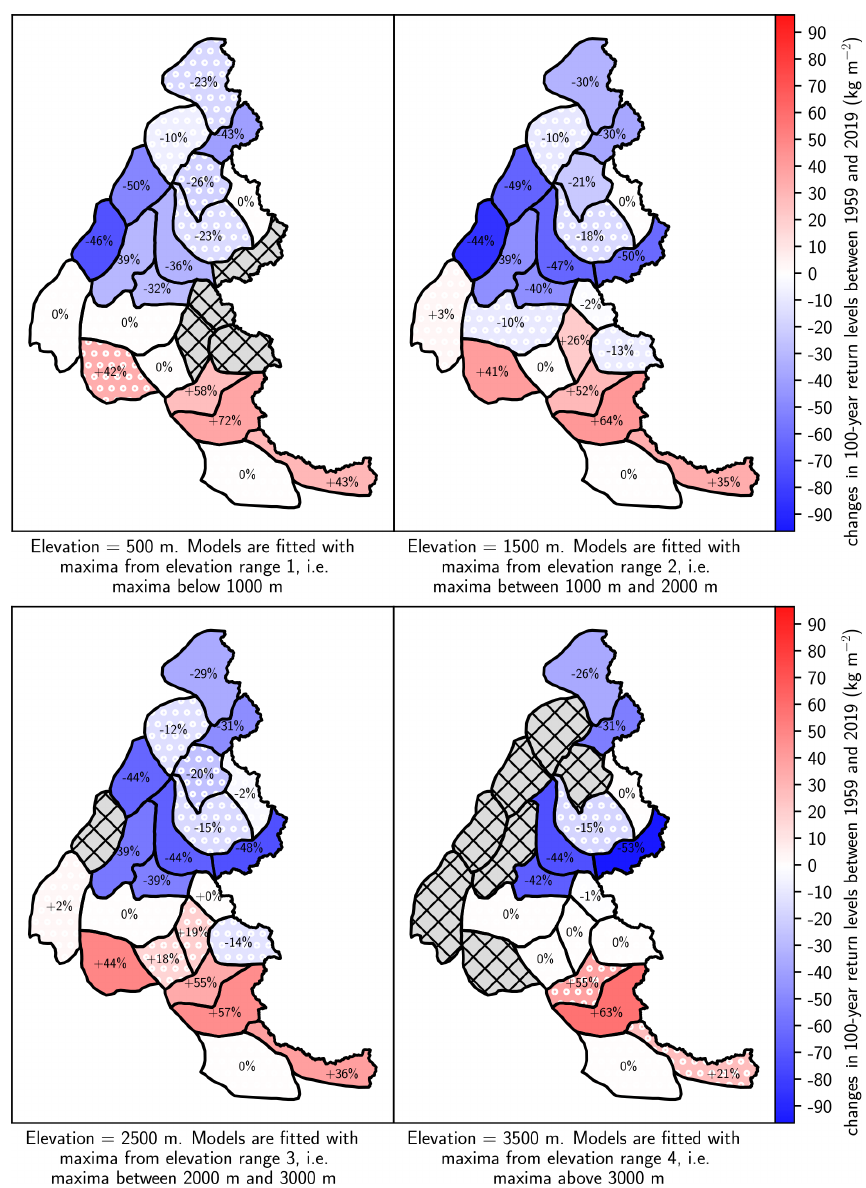
Figure D2. Changes in 100-year return levels of daily winter precipitation between 1959 and 2019 for each range of elevations. The corresponding relative changes are displayed on the map. Hatched grey areas denote missing data, e.g., when the elevation is above the top elevation of the massif. Changes in return levels are computed at the middle elevation for each range, e.g., at 1500m for the range 1000–2000m. Massifs with non-significant trends are indicated with a pattern of white